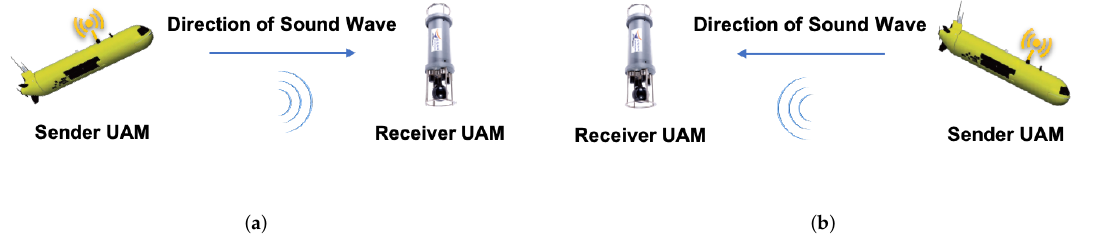
Figure 12. The possible attitudes of AUVs in the underwater. (a) the pitch of AUV is positive. (b) the pitch of AUV is